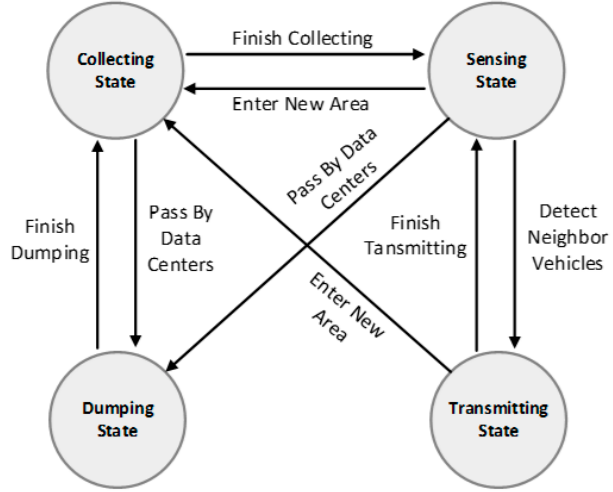
Figure 2. State transition diagram of the running states of mobile vehicles.